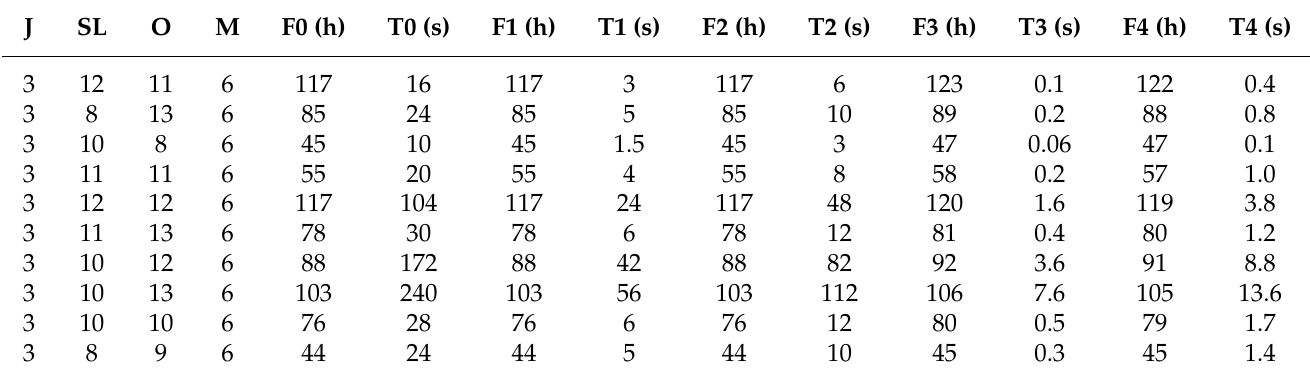
Table 7. Computational results of the developed resolution methods for small randomly generated instances.